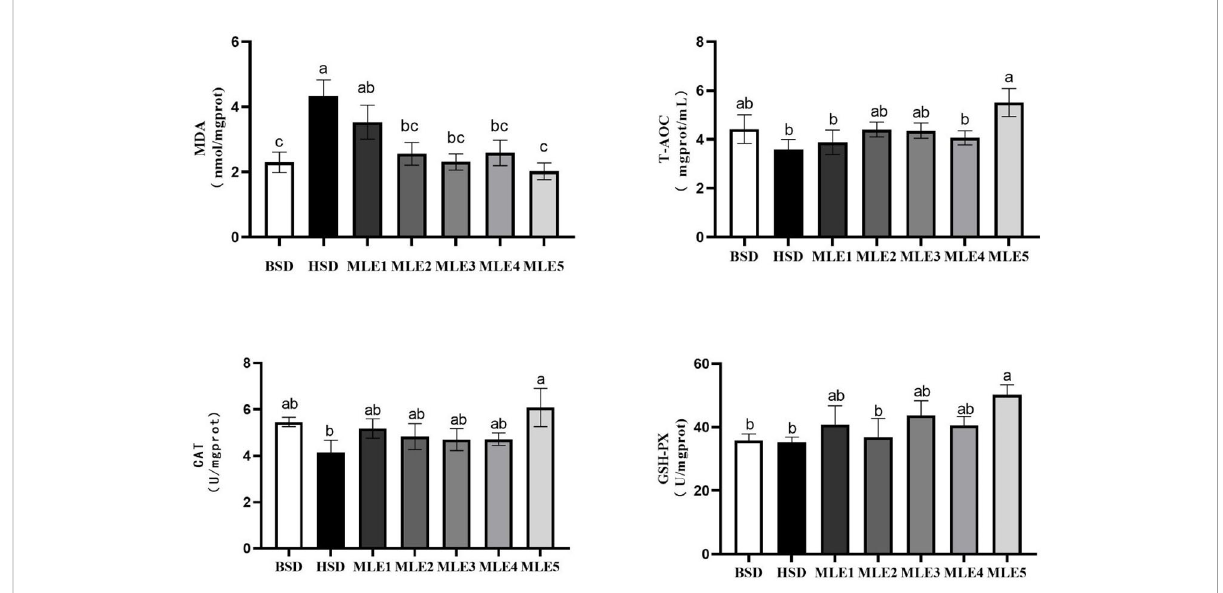
FIGURE 1 Effects of mulberry leaf extract on antioxidant enzymes of Micropterus salmoides fed high-starch diet diets. Values in each column with different superscripts have signi fi cant differences (p<